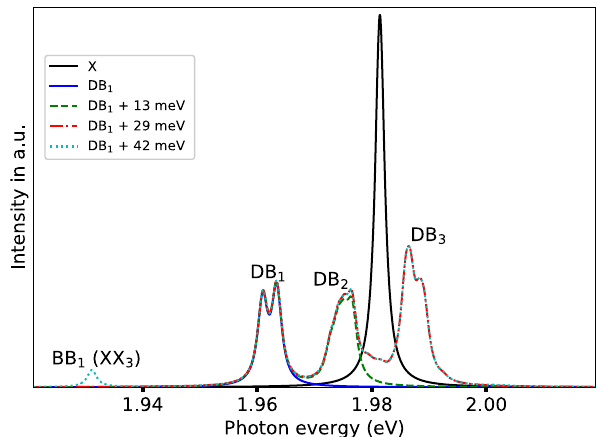
Fig. 2 Biexciton spectra calculated with increasing number of biexciton states. The labels above the peaks denote the biexciton state from which the peak originates. The black curve represents the exciton peak and the blue one the biexciton double peak at 1.96 eV, which originate from the dark – bright DB 1 state. The dashed green curve is the calculated biexciton spectrum including all the states up to 13 meV above the DB 1 state. At this energy, the DB 2 peak appears. The red dotted-dashed (cyan dotted) curve is the biexciton spectrum with the new peak from the DB 3 (respectively the bright – bright BB 1 ) biexciton state reached at 29 meV (respectively 42 meV) above the DB 1